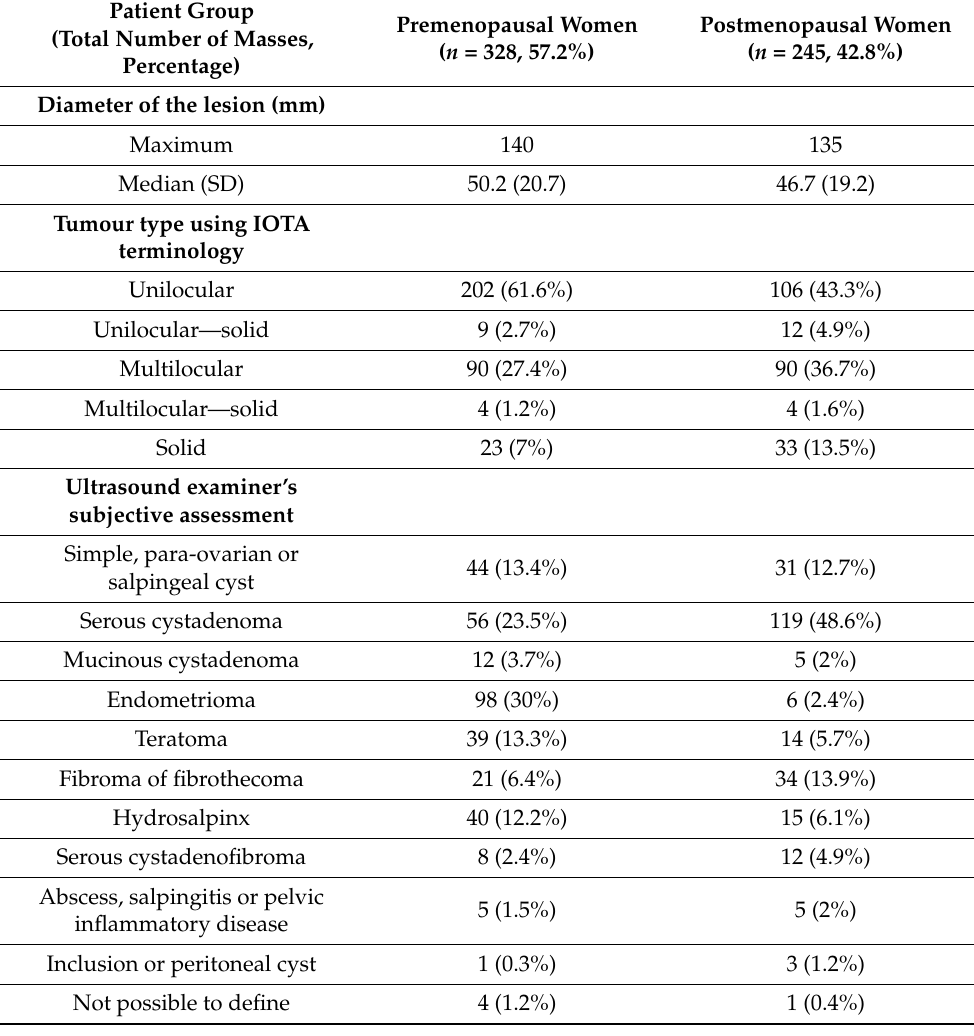
Table 2. Ultrasound characteristics and classification of adnexal masses at diagnosis (1st